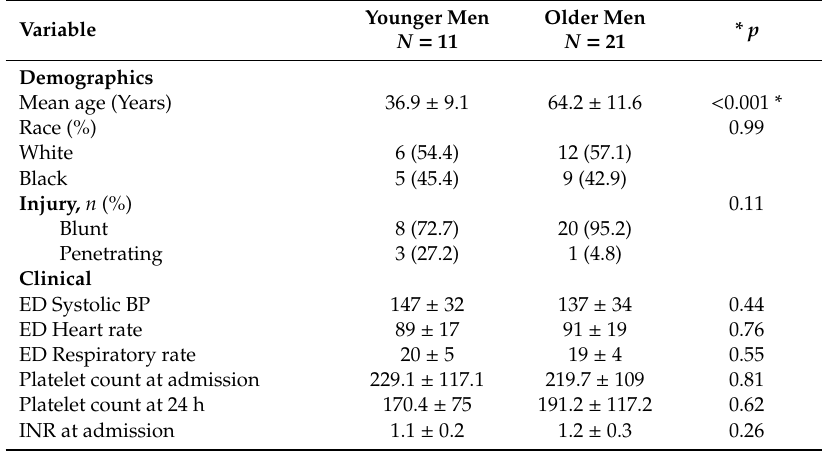
Table 2. Demographic, injury, and clinical characteristics of male trauma patients with ventilator-associated pneumonia